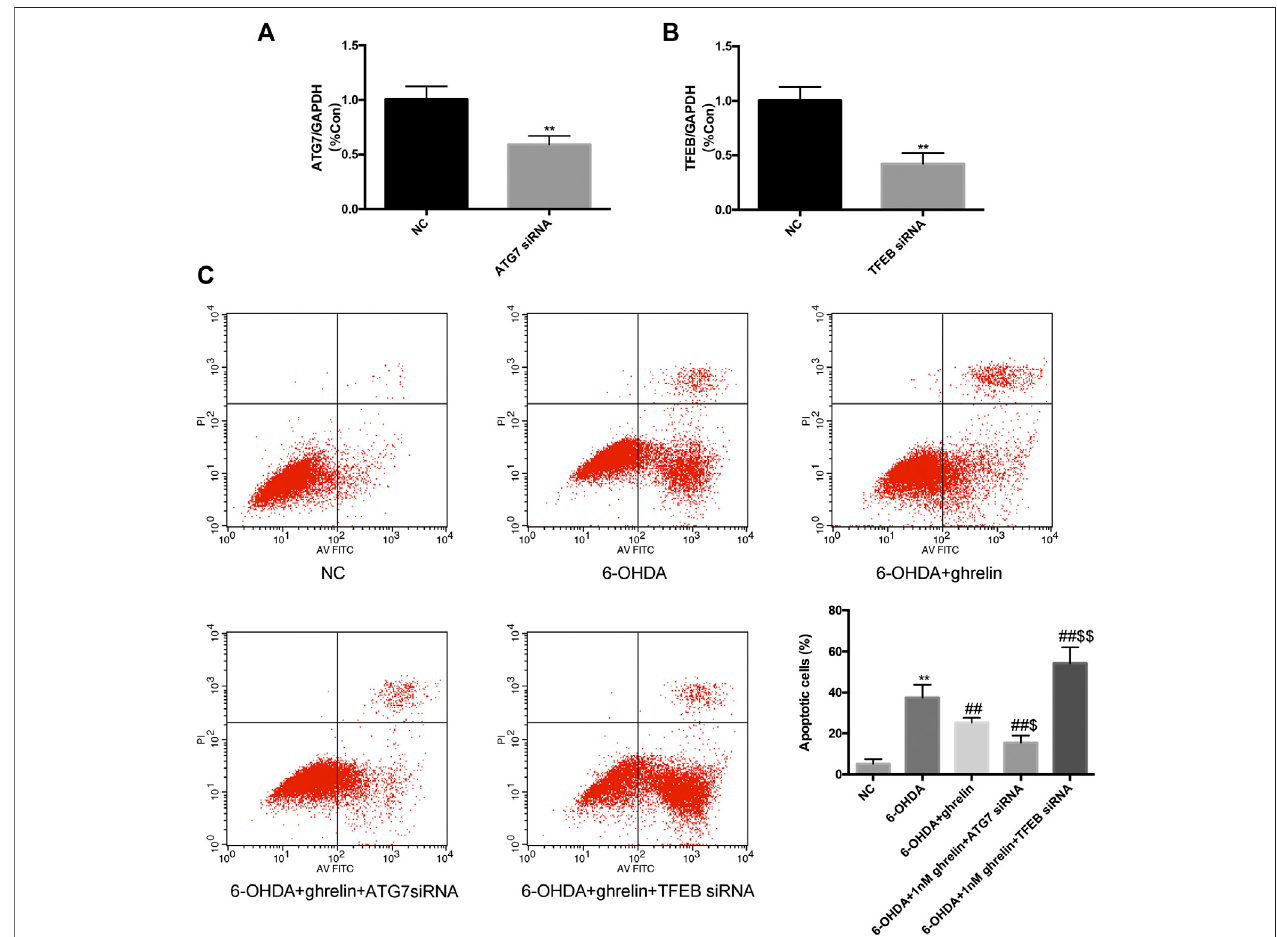
FIGURE6| DownregulatingAtg7couldboostwhiledownregulatingTFEBcouldabolishtheanti-apoptoticeffectofghrelinagainst6-OHDA-inducedneurotoxicity. (A) RT-PCR analysis of ATG7 mRNA level in SH-SY5Y cells transfected with ATG7 siRNA; ampli fi cation of GAPDH cDNA was performed and served as internal control. (B) RT-PCR analysis of TFEB mRNA level in SH-SY5Y cells transfected with TFEB siRNA; ampli fi cation of GAPDH cDNA was performed and served as internal control. (C) Cell apoptosis was evaluated with Annexin V-PI/FITC kit through a fl ow cytometer. Data are presented as mean ± SD; ** p < 0.01 vs. the NC group, ## p < 0.01 vs. the 6-OHDA group, $ p < 0.05 vs. the 6-OHDA + ghrelin group, $$ p < 0.01 vs. the 6-OHDA + ghrelin group, n (cid:2) 5.